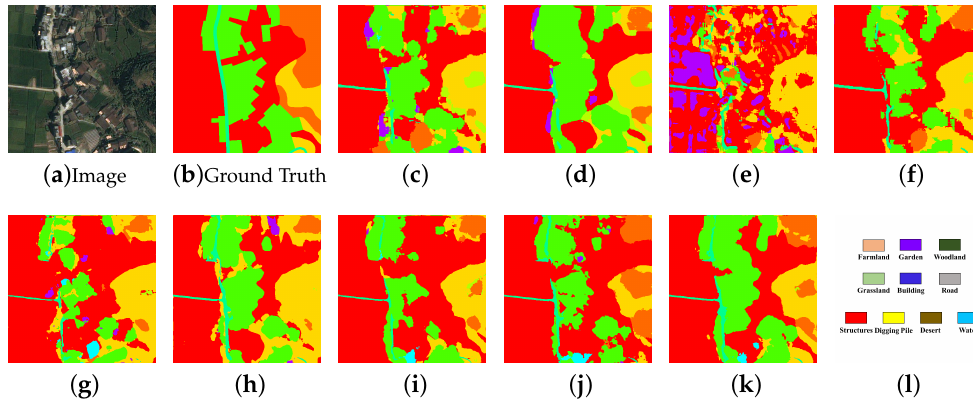
Figure 18. Segmentation results on Songxi dataset with different models. ( a ) Image; ( b ) Ground Truth; ( c ) FCN-8s; ( d ) PSPNet; ( e ) Deeplab V3+; ( f ) HRNet V2; ( g ) SDFCN V1; ( h )